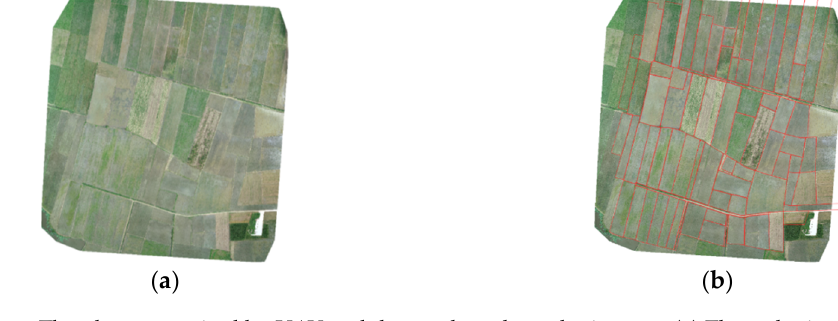
Figure 3. The photos acquired by UAV and the result as the ortho images. ( a ) The ortho image for one village processed after Pix4D; ( b ) the image merged with vector data for field blocks.